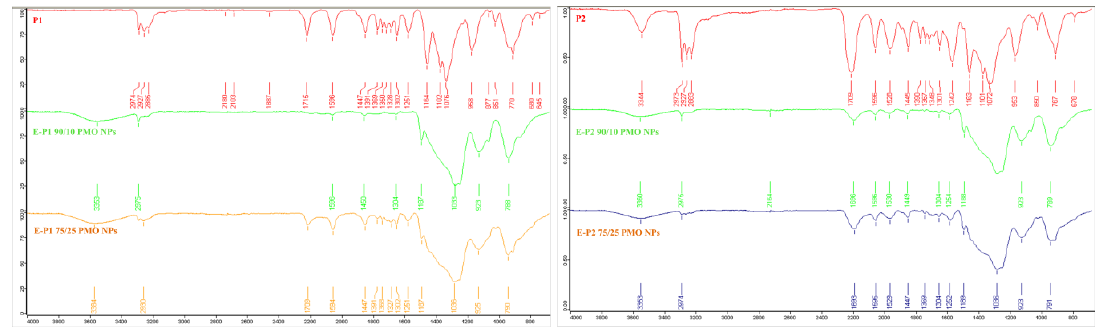
Figure 6. FTIR of Pn and E-Pn PMO NPs .